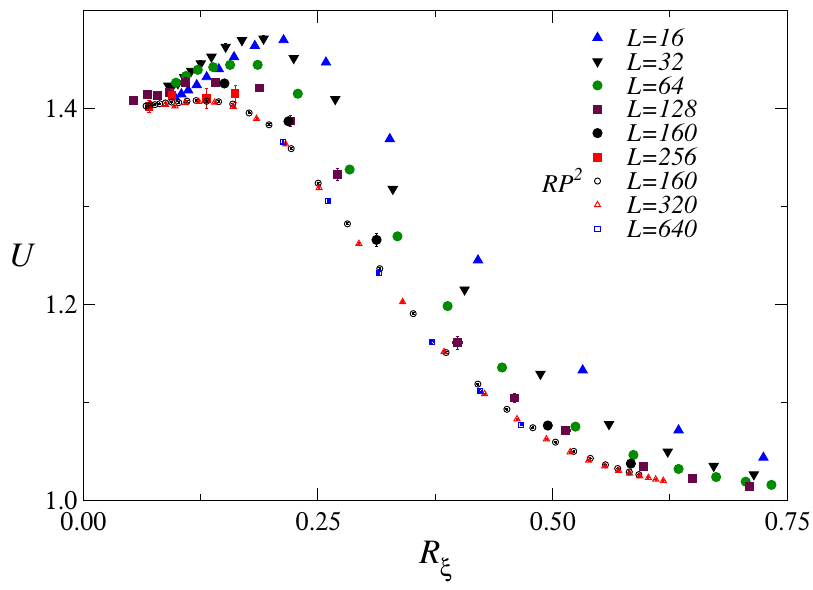
Figure 2 . Plot of U versus R ξ for N c = 3 , N f = 3 , v = 0 , and γ = 0 . Data are compared with analogous data on large lattices computed in the RP 2 model [25].